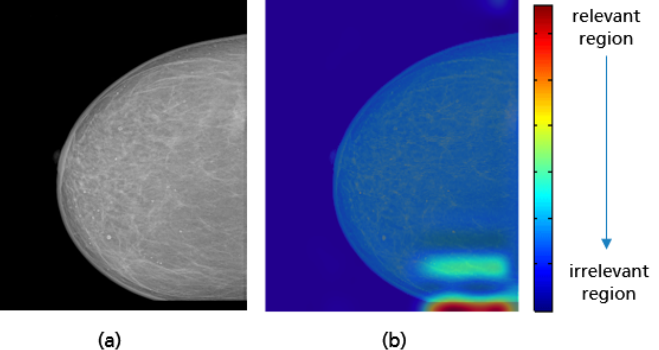
Figure 33. Example of CC view misclassified by the model with a small missing breast part ( a ) in the lower quadrant, and the Grad-CAM visualization ( b